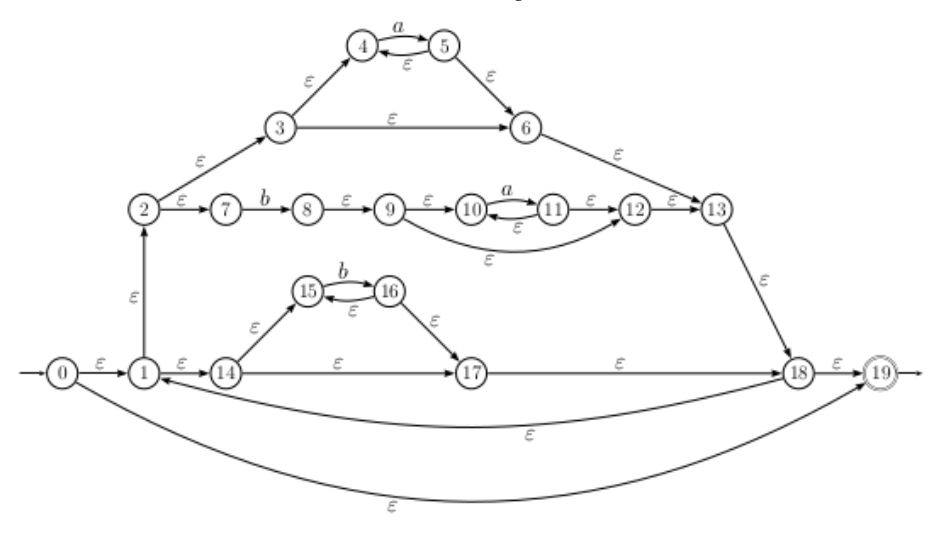
Figure 2. Thompson automaton T E